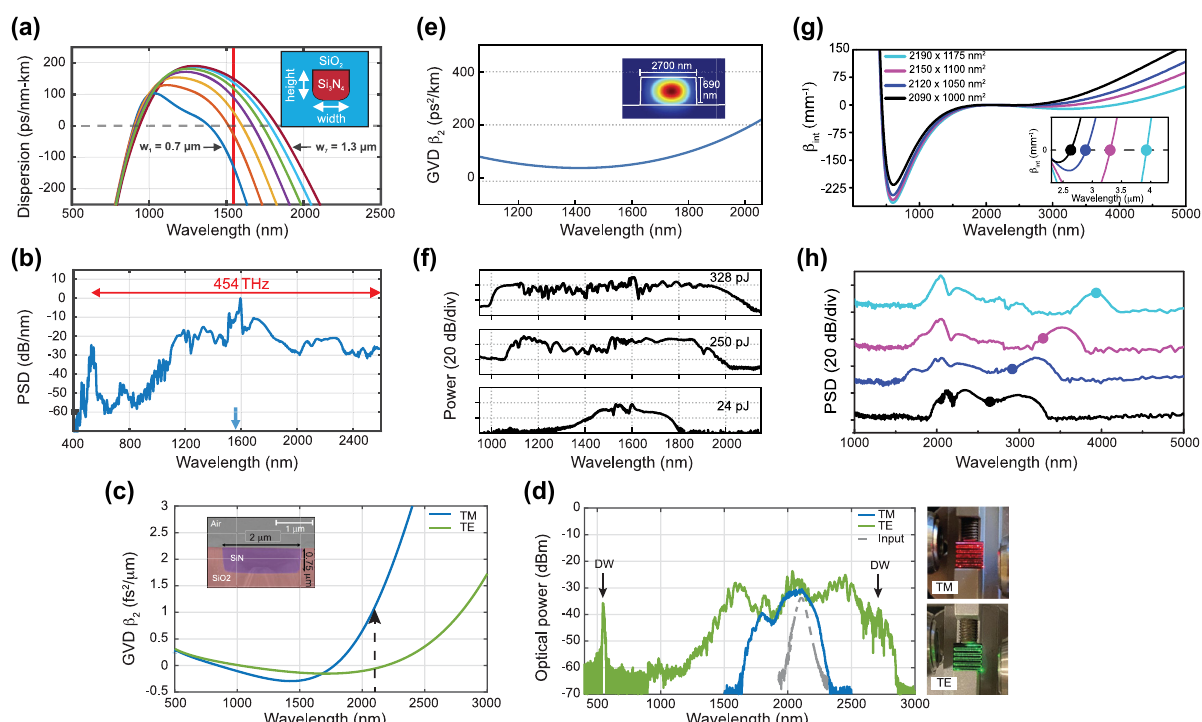
Figure 10: SCG in SiN platforms. (a) Simulated dispersion for the fundamental TM-mode in waveguides with a height of 900 nm and different widths, inset: cross section, and (b) output spectrum from 1000 nm × 900 nm with pump wavelength indicated by the arrow. (c) Simulated GVD for the fundamental TE and TM mode, dotted arrow indicates pump wavelength, inset: SEM image of the waveguide and (d) output spectra for TE (anomalous) and TM (Andi) mode coupling and attenuated input pump pulse, photographs of the waveguide taken from the top showing red scattered light for TM excitation (third harmonic of the pump initiated from intermodal phase matching right from the input of the waveguide), and green scattered light for TE excitation (DW generated a few mm after the beginning of the propagation, following soliton fission). (e) Simulated GVD of the waveguide with a geometry of 2700 nm × 690 nm showing all normal dispersion, inset: Simulated TE mode profile, and (f) measured output spectrum using different energies for the input pulses. (g) Integrated dispersion for four waveguide geometries, inset: expected MIR phase matching points, and (h) experimental output spectra (same color convention as for (g)). Panels (a) and (b) adapted from [79]. Panels (c) and (d) adapted from [80]. Panels (e) and (f) adapted from [81]. Panels (g) and (h) adapted from